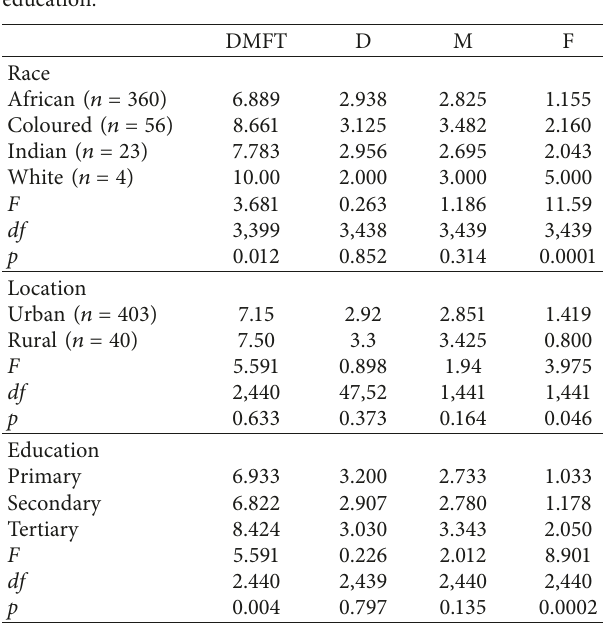
Table 3: ANOVA comparison of DMFT with race, location,